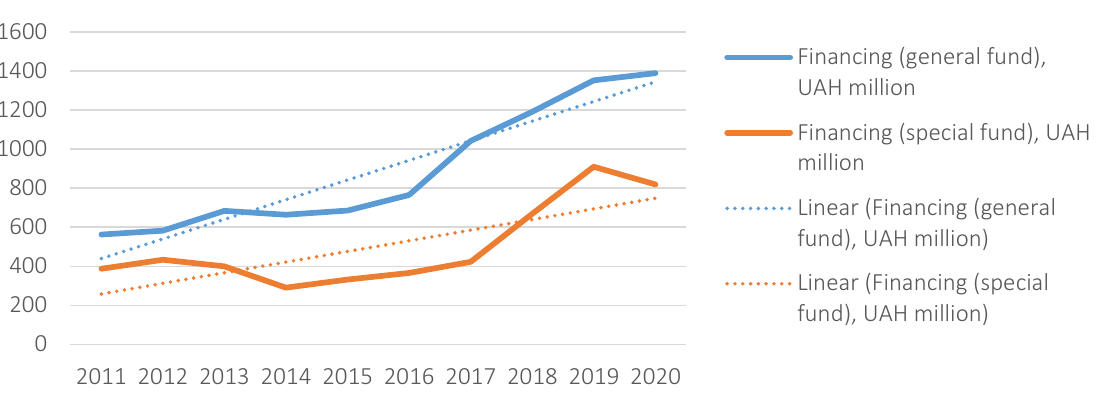
Figure 1. Change in the amount of funding of the University under the general and special fund,